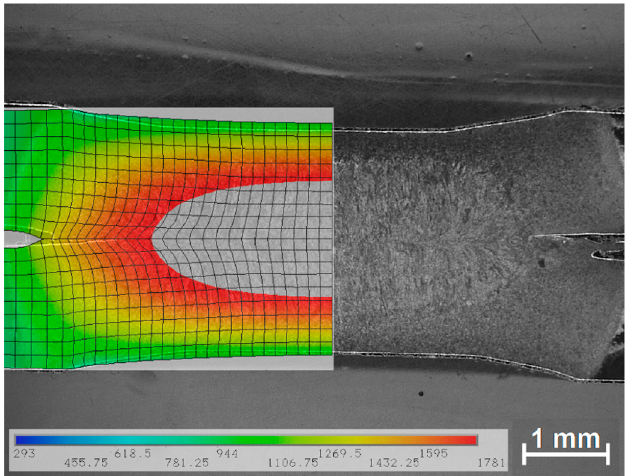
Figure 14. Macrosection of weld nugget in comparison to computed result, the latter half-translucent; temperature profile is in K, gray surface represents melt.